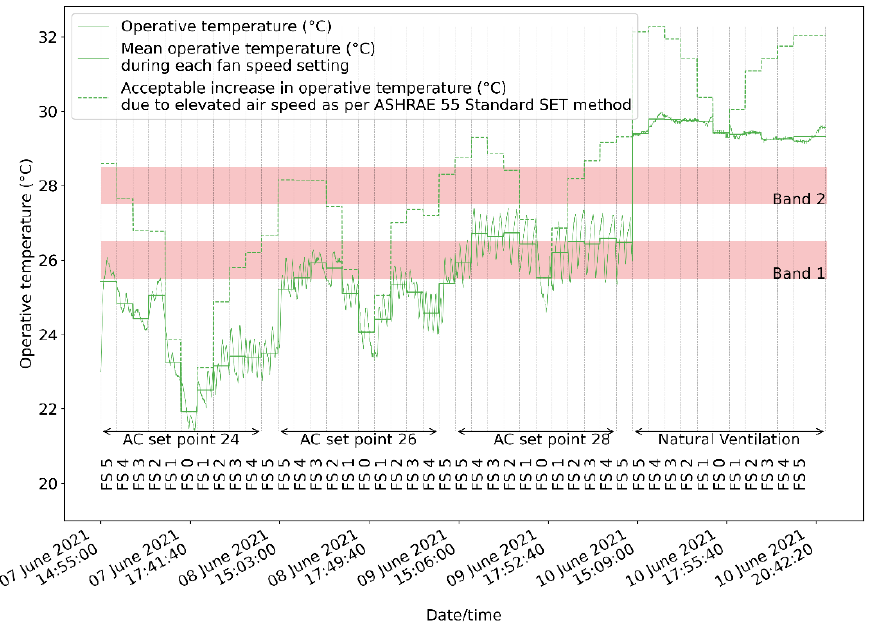
Figure 12. Indoor operative temperature, set point temperatures and fan speeds during the second experiment. Please see discussion for explanation of bands one and two. FS = Fan Speed.